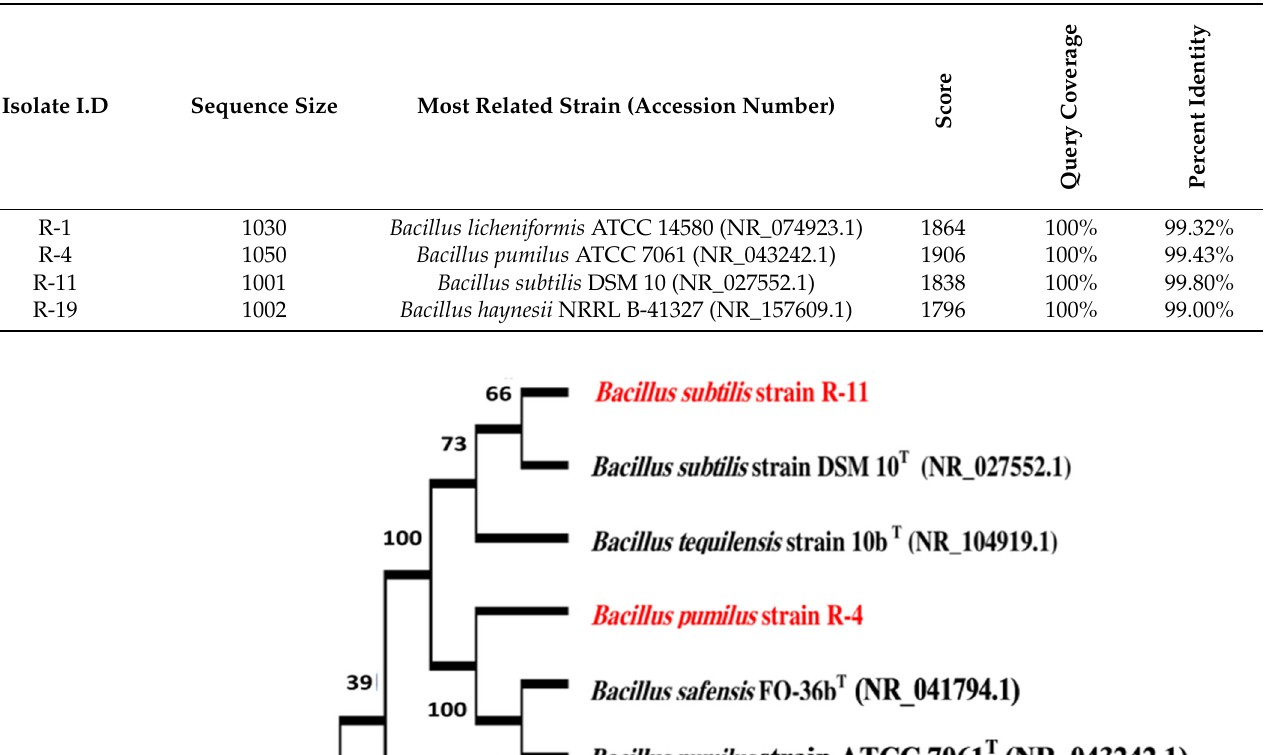
Table 3. Results of the NCBI Blast search.